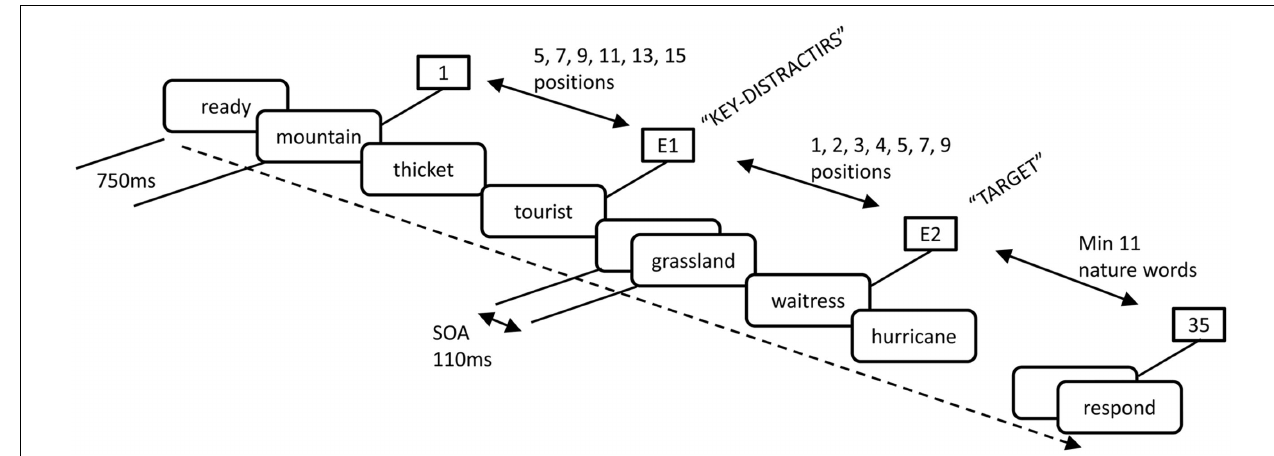
FIGURE 1 |Task schema for the key-distractorAB task; adapted from Barnard et al. (2004).